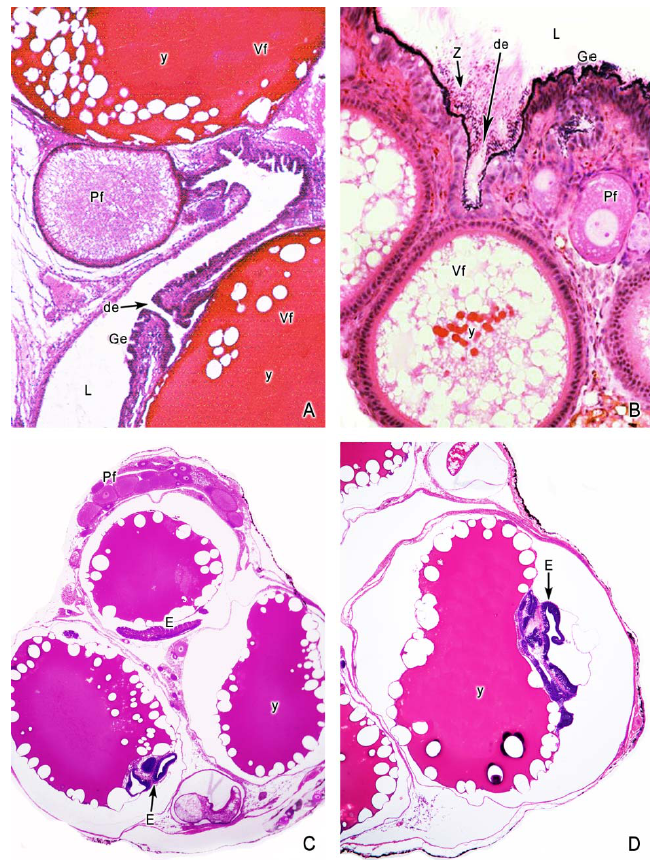
Figure 5. The delle and early intrafollicular embryogenesis. ( A ) Ovary of Poecilia latipinna presenting the delle (de) structure as a funnel ‐ like invagination of the ovarian lining at the periphery of a vitellogenic oocyte (Vf). The delle is opened to the ovarian lumen (L). The germinal epithelium (Ge) borders the ovarian lumen. The yolk (y) is fluid. A previtellogenic oocyte (Pf) with lipid droplets in the ooplasm is also seen. 32×. ( B ) Ovary of Heterandria formosa with a vitellogenic oocyte (Vf) presenting the delle (de), which contains abundant spermatozoa (Z). The delle is opened to the ovarian lumen (L). This species has scarce yolk (y) developing microlecithal eggs. A previtellogenic oocyte (Pf) with basophilic ooplasm is also seen. The germinal epithelium (Ge) borders the ovarian lumen. 78×. ( C ) Ovary of Gambusia affinis with embryos (E) during early development; the fluid yolk (y) is abundant. Previtellogenic oocytes (Pf) are seen. 20×. ( Poecilia latipinna ) Detail of the previous figure with one embryo (E) during early development; and the fluid yolk (y) at the ventral side of the embryo. 32×.